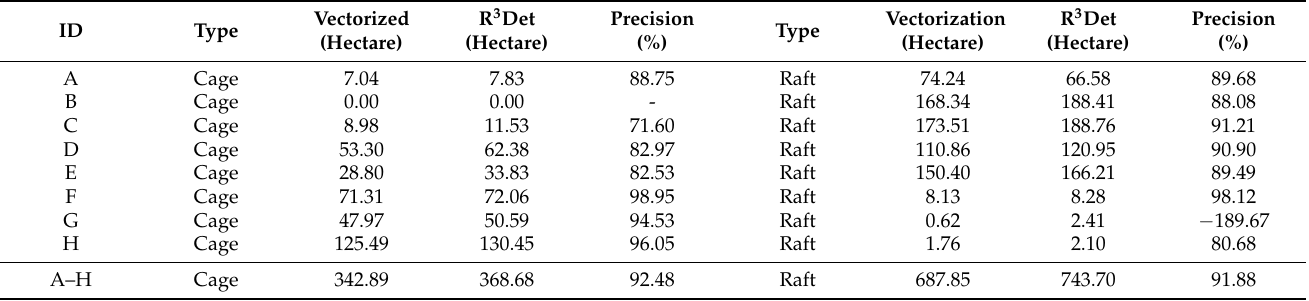
Table 7. Extraction precision of the R 3 Det model for the area of the aquaculture